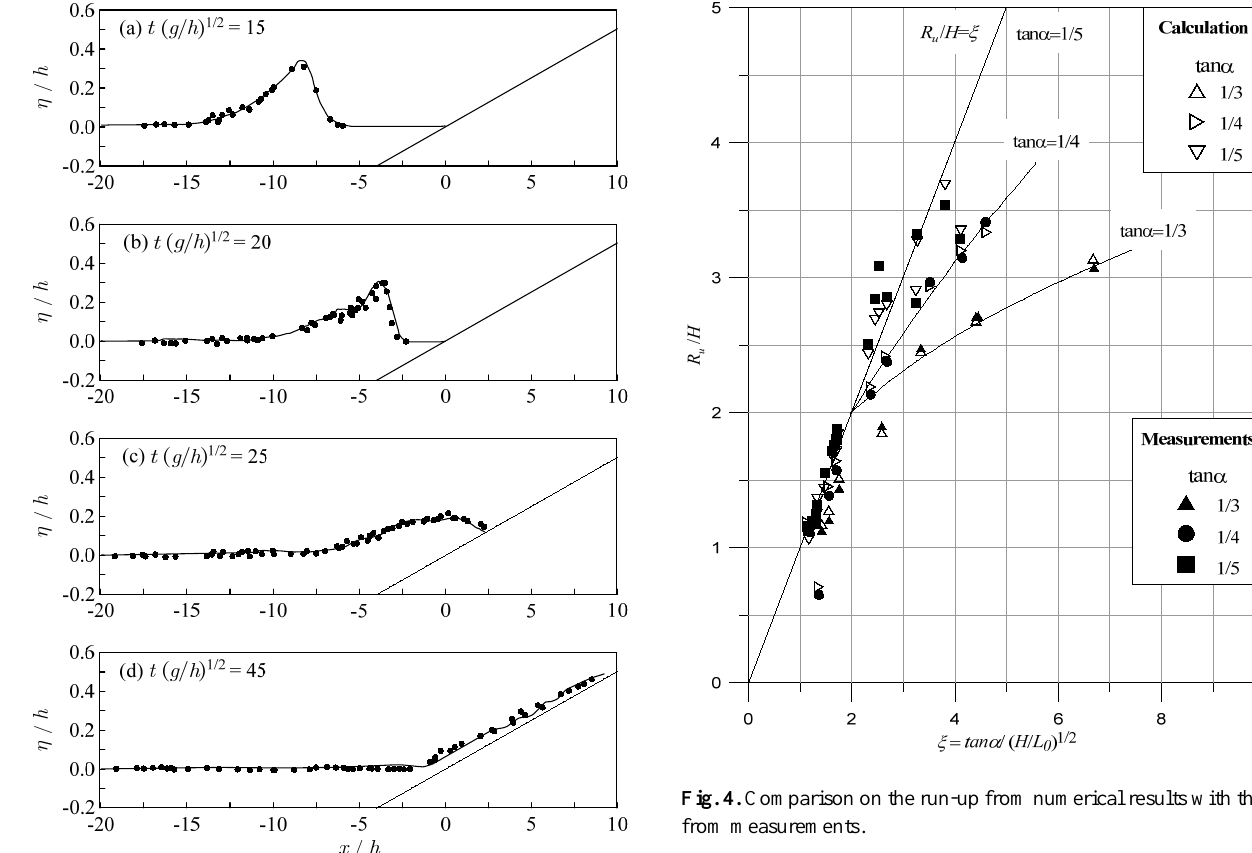
R H versus  in logarithmic coordinate for different 2 u